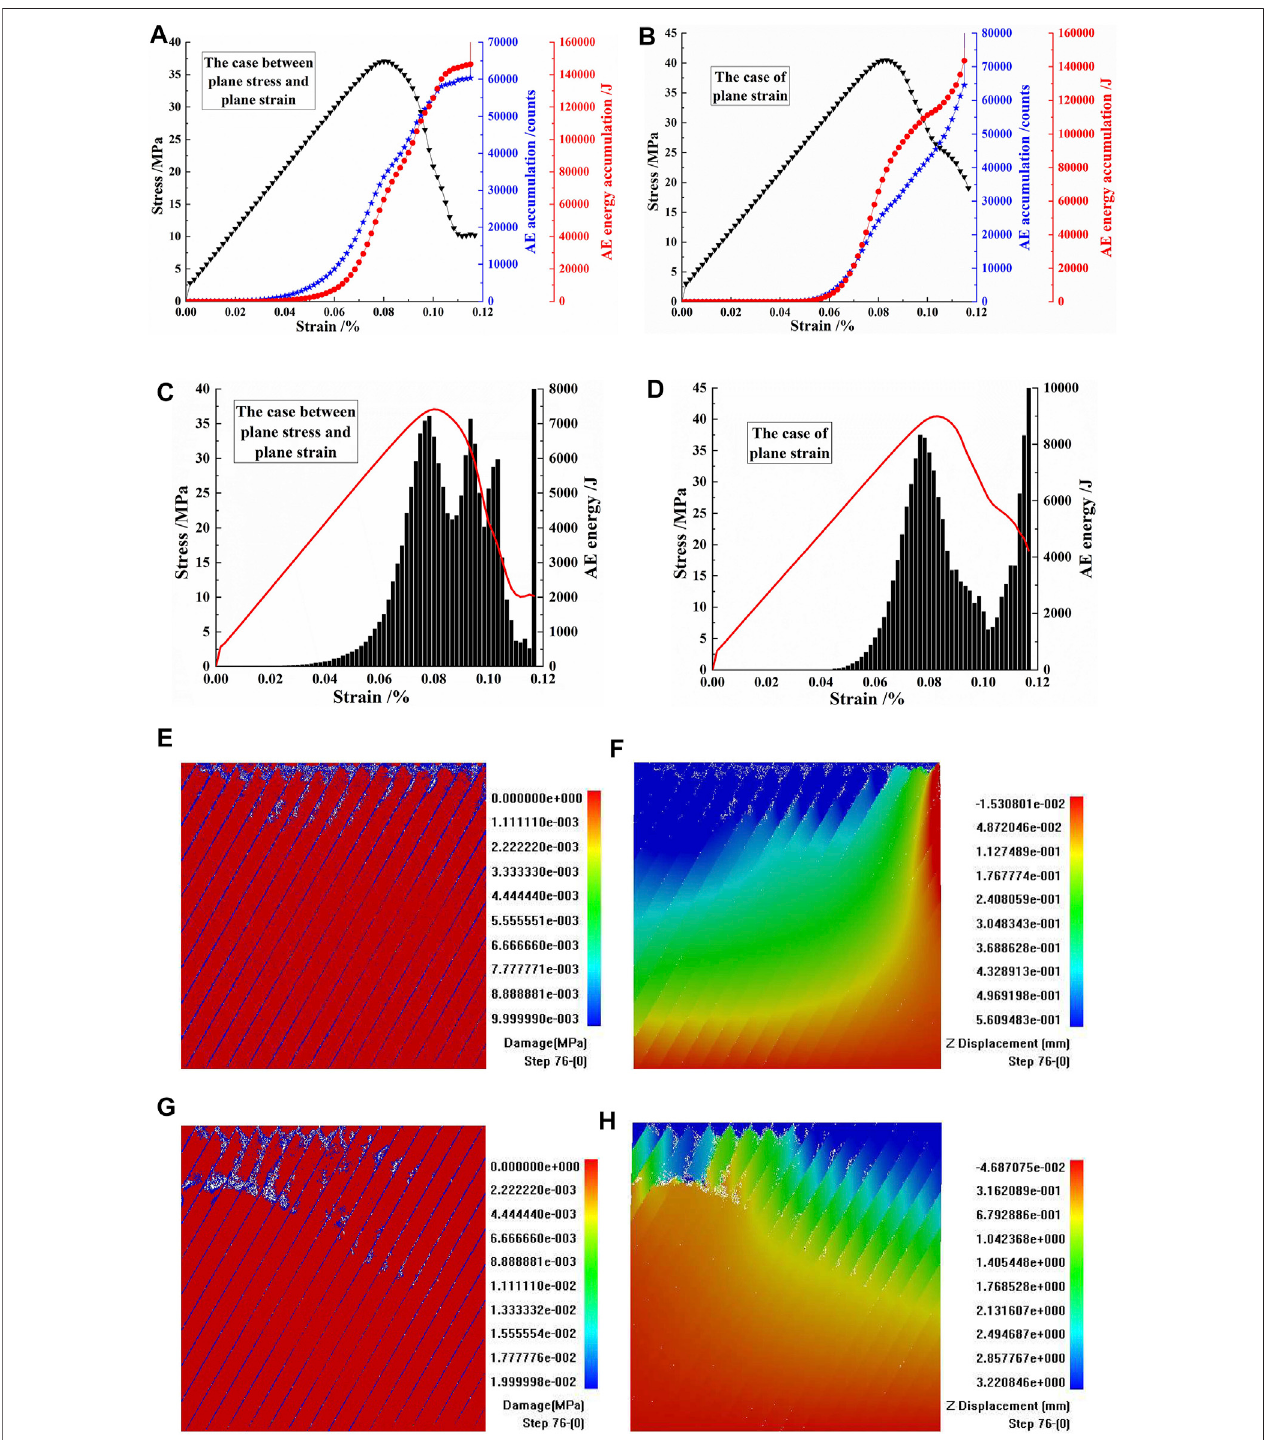
FIGURE 13 | (A,B) The stress – strain curves, acoustic emission (AE) accumulations, and AE energy accumulations of columnar jointed basalts (CJBs) in the directionparalleltothecolumnaxis, β (cid:2) 30 ° ,forthecasebetweenplanestressandplanestrainandthecaseofplanestrain,withacon fi ningpressureof8 MPa. (C,D) The stress – strain curves and AE energies of CJBs, β (cid:2) 30 ° , for the case between plane stress and plane strain and the case of plane strain. (E,F) Damage and displacement diagrams, β (cid:2) 30 ° , for the case between plane stress and plane strain. (G,H) Damage and displacement diagrams, β (cid:2) 30 ° , for the case of plane strain.